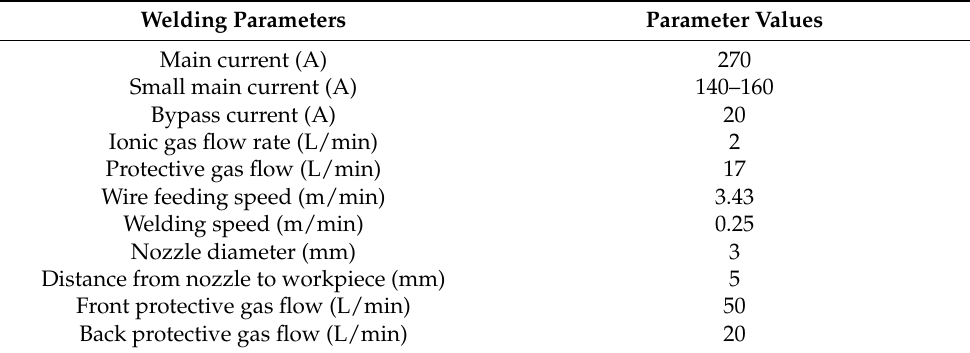
Table 2. Experimental parameters used in this study. Welding Parameters Parameter Values Main current (A)